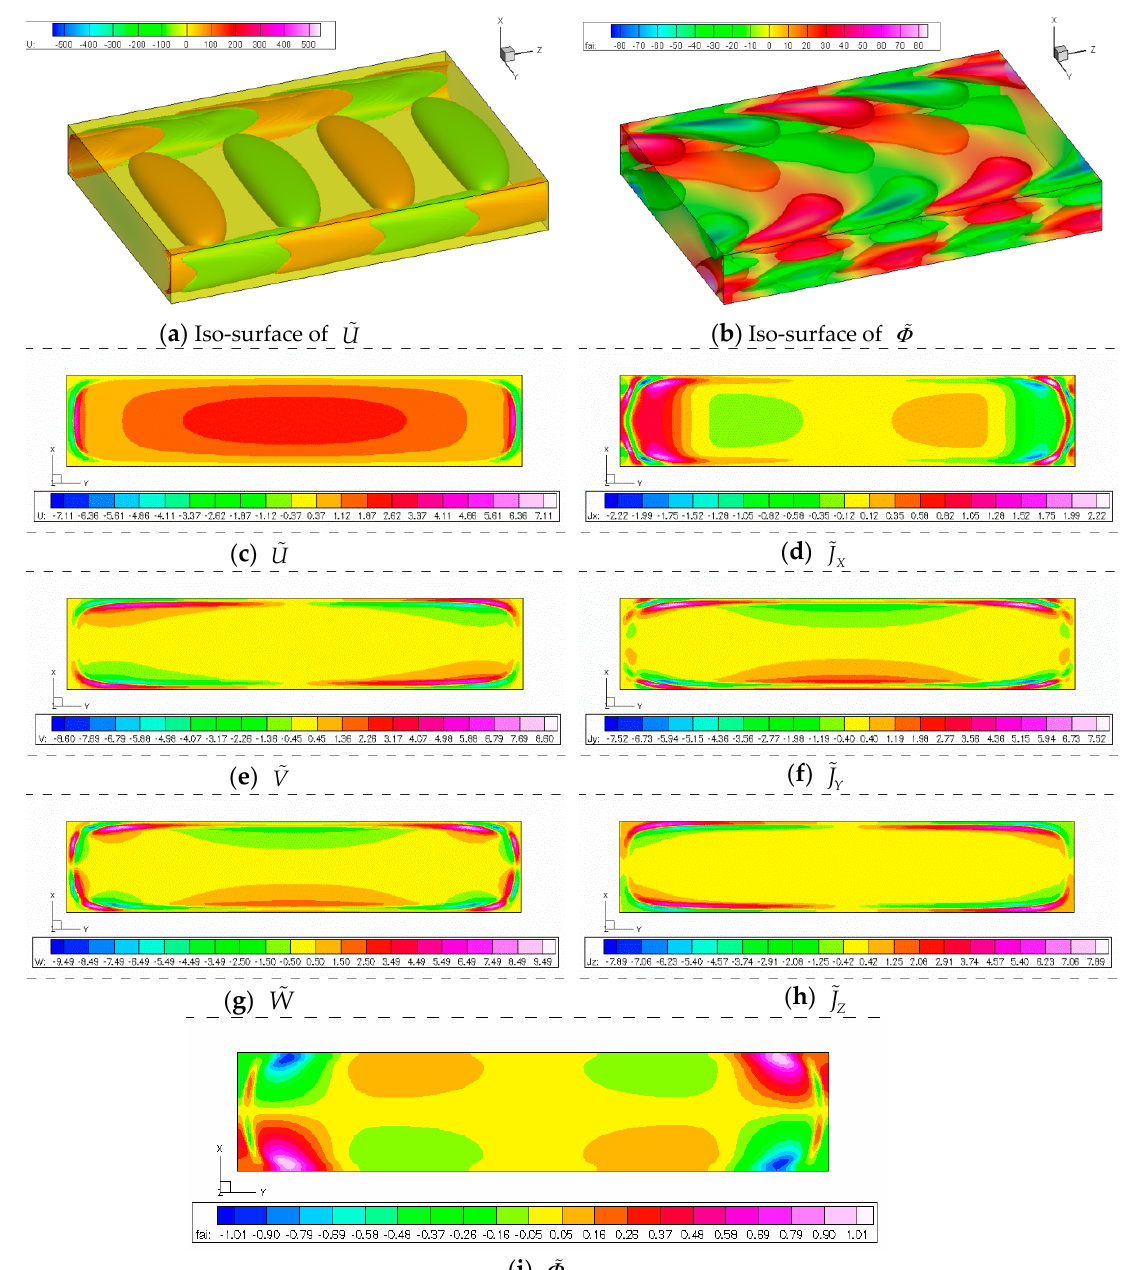
Figure 7. Contour maps at the critical state when external uniform magnetic field is applied in X -direction ( B = e x ) at A = 5, Ha = 1, α c = 0.8737, Re c = 20,140, and S Ic = − 0.1680. ( a ) Iso-surface of vertical component of velocity; ( b ) iso-surface of electric potential; ( c ) contour map of (cid:101) U ; ( d ) contour map of (cid:101) J X ; ( e ) contour map of (cid:101) V ; ( f ) contour map of (cid:101) J Y ; ( g ) contour map of (cid:101) W ; ( h ) contour map of (cid:101) J Z ; ( i ) contour map of (cid:101)